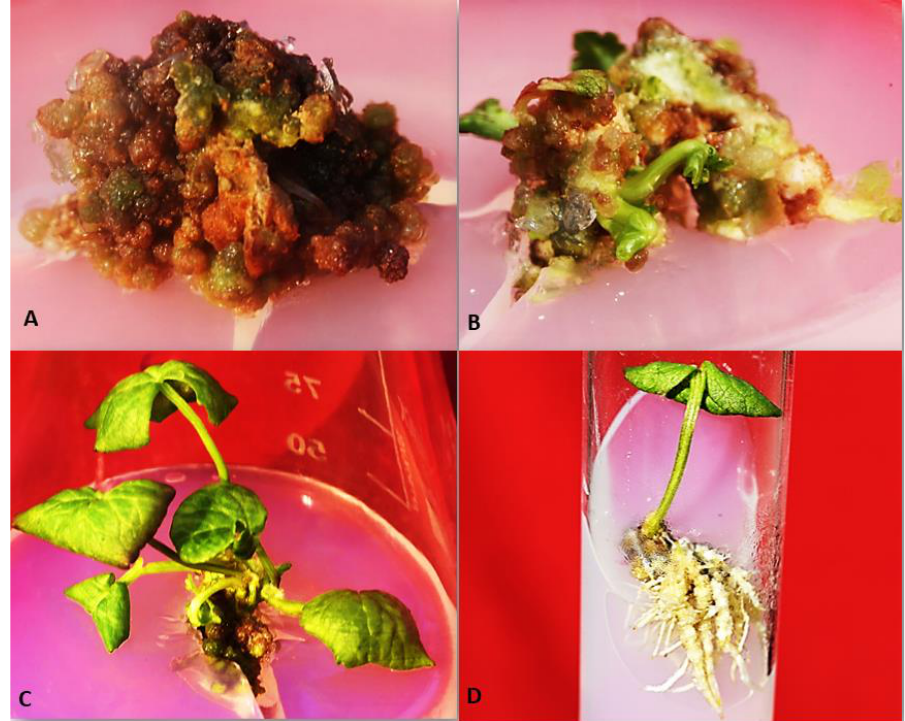
Figure 1. ( A ) Callus formation on the 12th day of inoculation on MS media augmented with BA (6 µ M) + NAA (0.8 µ M). ( B ) Multiple shoot initiation from callus cultures of C. asiatica in the first week of subculture on MS media augmented with BA (8 µ M) + KN (0.6 µ M). ( C ) Shoot multiplication at the 2nd passage of subculture on MS media augmented with BA (8 µ M) + KN (0.6 µ M). ( D ) Re- generation of roots from shoots of C. asiatica cultured on MS medium augmented with NAA 1.5 µ M. (Unpublished photographs of Dr. Anwar